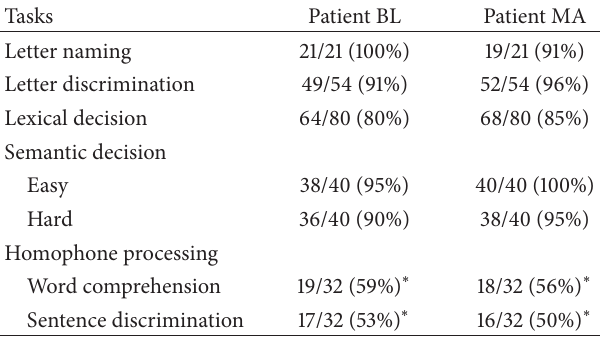
Table 1: Performances of patients BL and MA on Sartori’s battery [20]: correct responses.